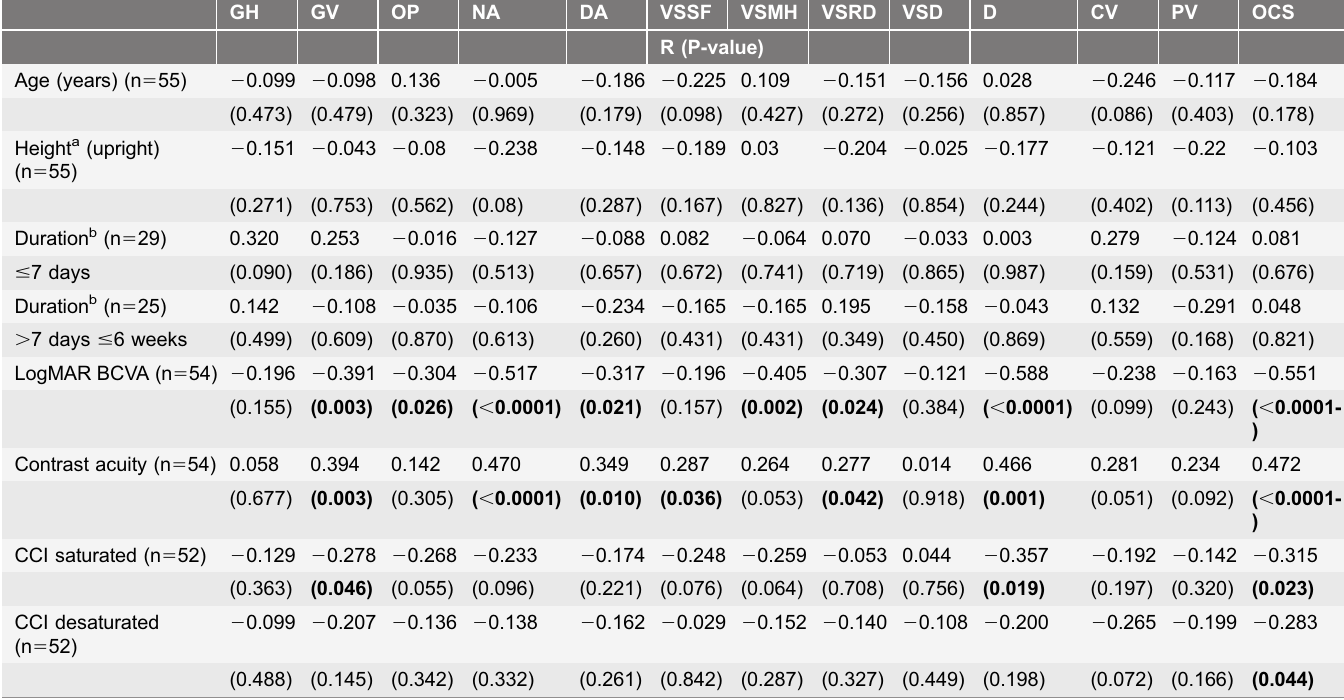
Nominal significant values are indicated in bold. NEI VFQ-25: National Eye Institute Visual Functioning Questionnaire-25, GH: General Health, GV: General vision, OP: Ocular pain, NA: Near activities, DA: Distance activities, VSSF: Vision Specific Social Functioning, VSMH: Vision Specific Mental Health, VSRD: Vision Specific Role Difficulties, VSD: Vision Specific Dependency, D: Driving, CV: Color Vision, PV: Peripheral Vision, OCS: Overall Composite Score. BCVA: best corrected visual acuity, CCI: Color vision Confusion Index. a Height of the retinal detachment in an upright position. b Duration of macular